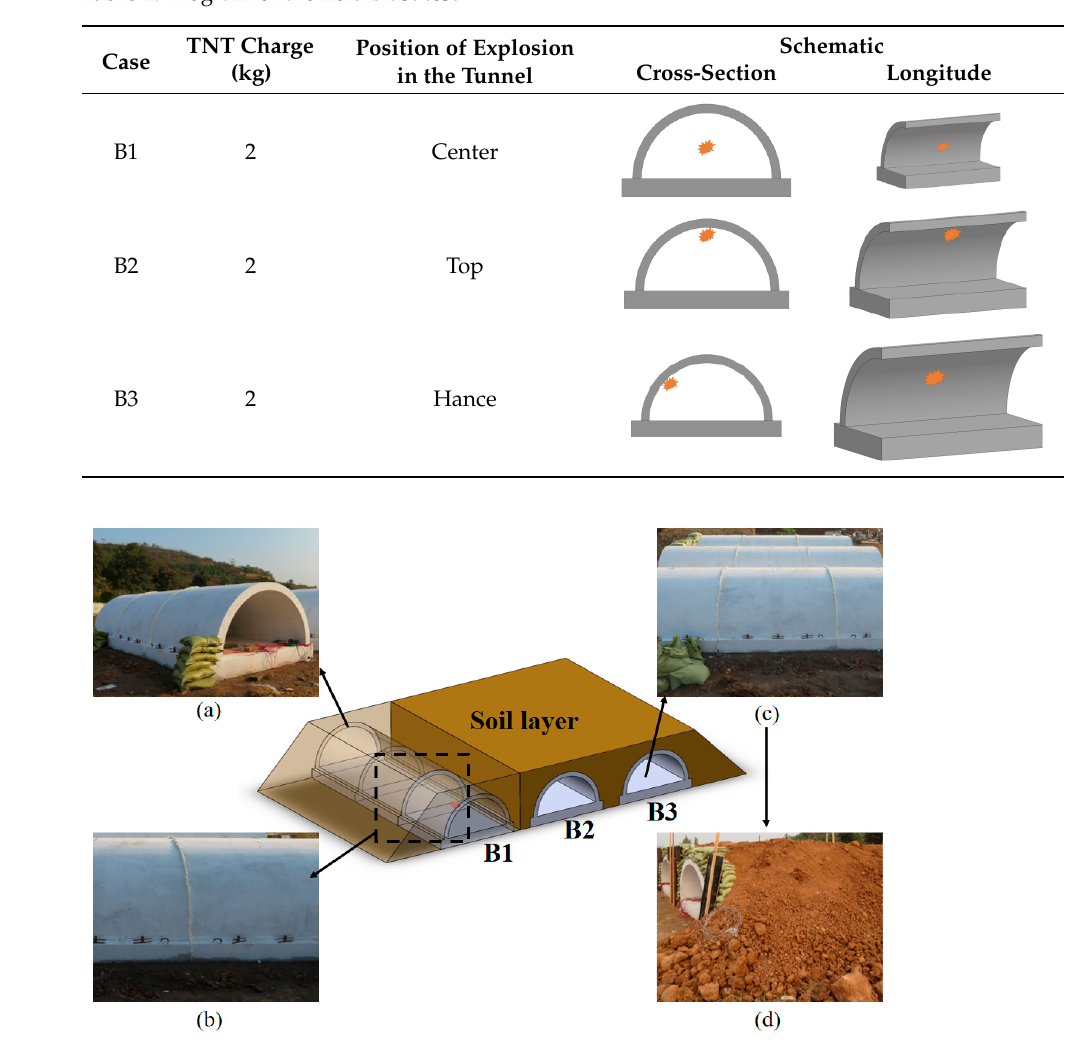
Figure 2. Test setup: ( a ) Scene photo of the tunnel specimens; ( b ) Details of foam filling; ( c ) Prepare for covering soil; ( d ) Finish covering.